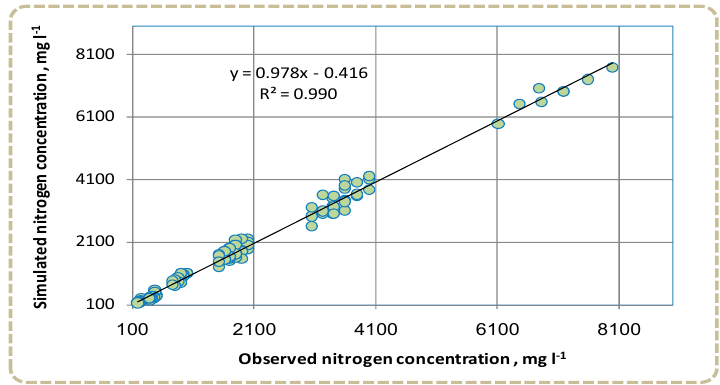
Figure 9. Observed and simulated nitrogen concentration of the soil layer for all treatments during the 2017/2018 and 2018/2019 seasons for different treatments: drainage water from fish farms (DWFF), fresh irrigation water (IW) and nitrogen (N).